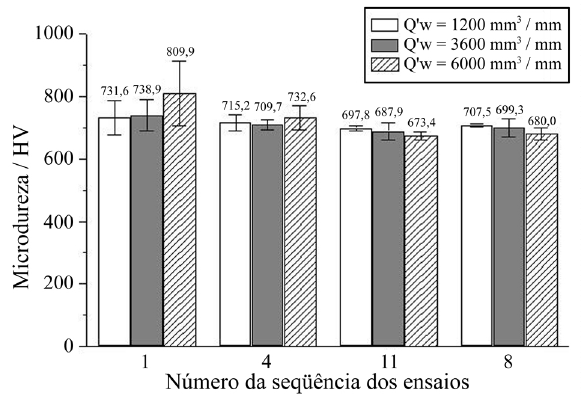
Figura 9. Valores de microdureza Vickers, realizada em amostras colhi- das do material retificado, à valores de volume removido pré-estabeleci- dos, para os ensaios 1, 4, 8